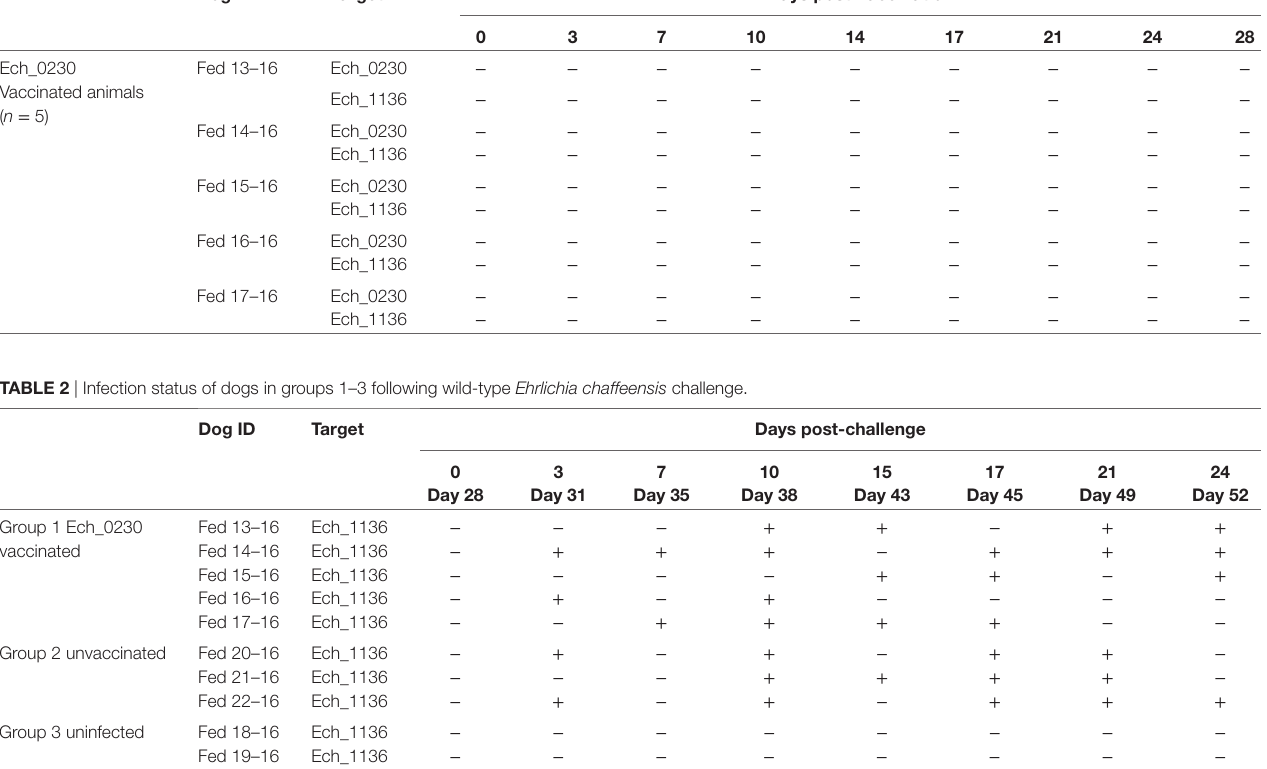
TaBle 1 | Infection status of dogs vaccinated with the Ech_0230 mutant. Dog iD